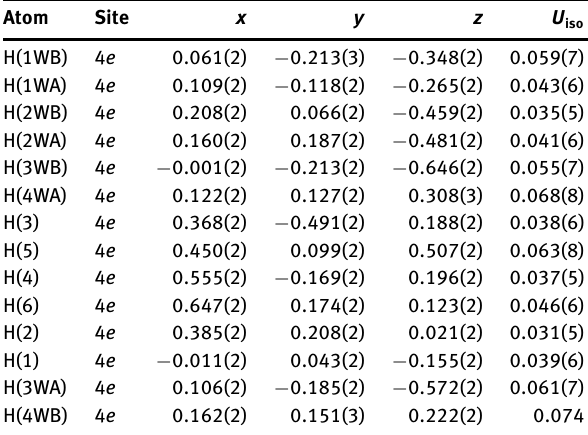
Table 2: Fractional atomic coordinates and isotropic or equivalent isotropic displacement parameters (Å 2